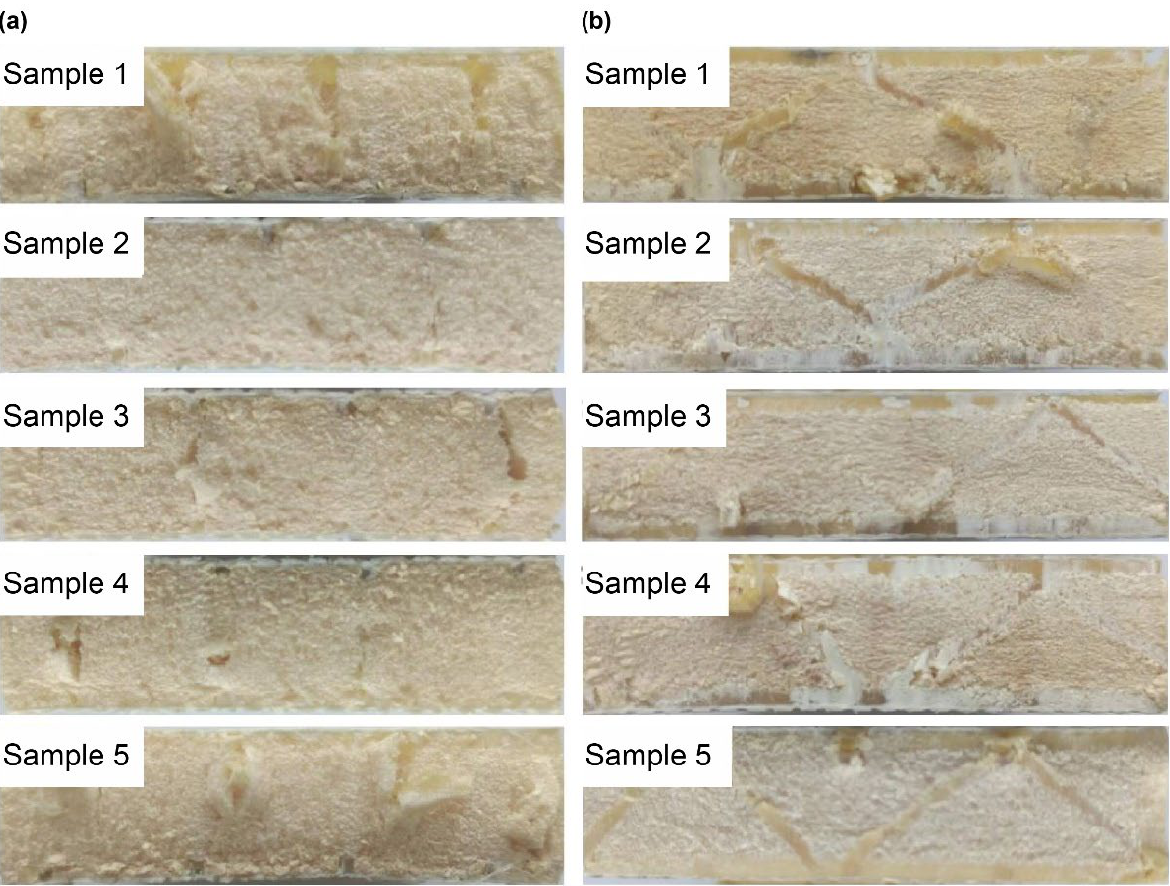
Figure 21. Side images demonstrating crack failure of the flat compression samples ( a ) and samples ( b ) after the flat compression test.